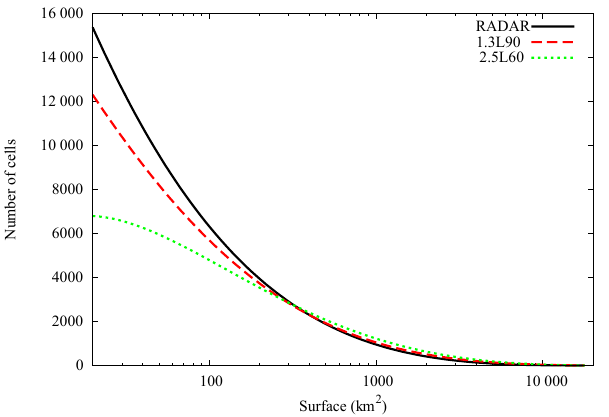
Figure 7. Distribution of the number of convective cells against their size represented by an estimate of the cloudy area, as de- rived from the data of the French radar network (40dBz reflec- tivity detection level, solid black curve), from the 1.3km, 90-level AROME version (dashed red curve) and from the 2.5km, 60-level AROME (dotted green curve). The statistics have been aggregated over 48 convective days of 2012. Adapted from Brousseau et al. (2016).